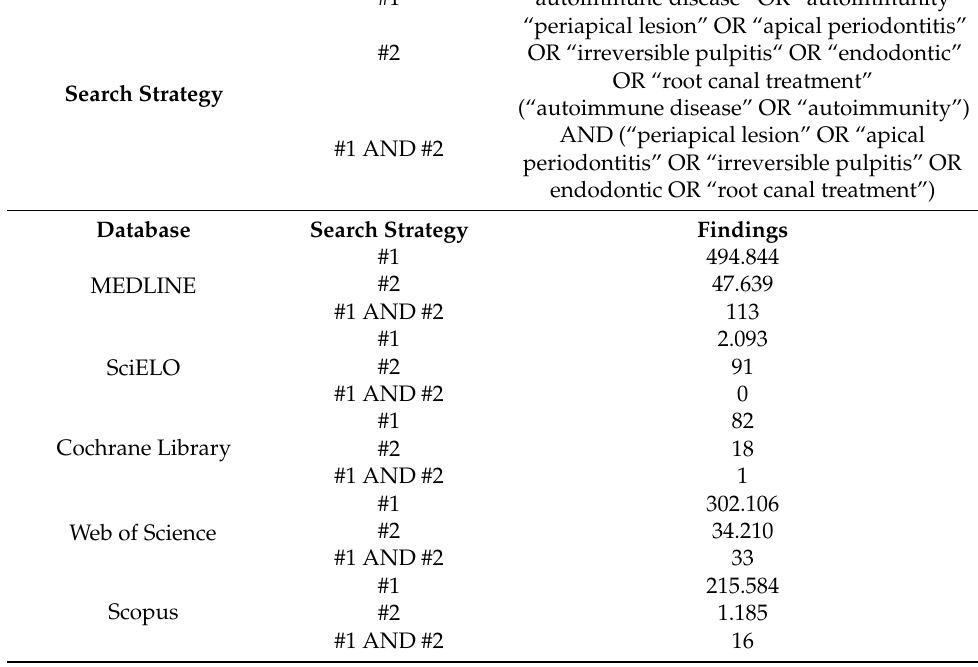
Table 3. Search strategy and findings of each